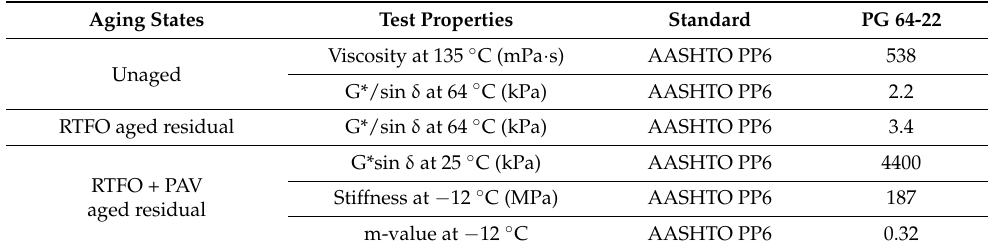
Table 1. PG 64-22 asphalt binder properties [4].